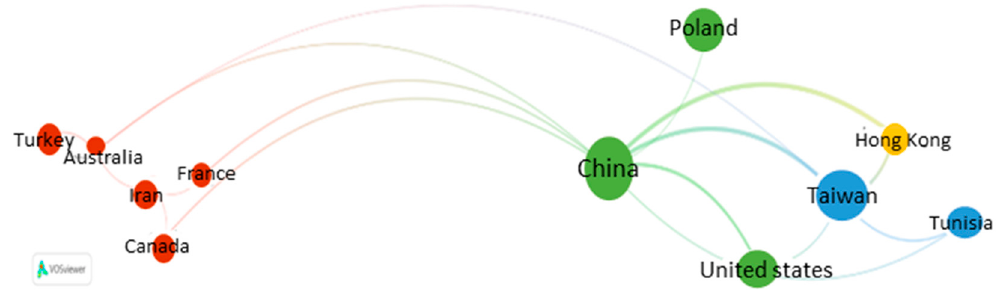
Figure 4. Co-authorship countries (source: VOSviewer).